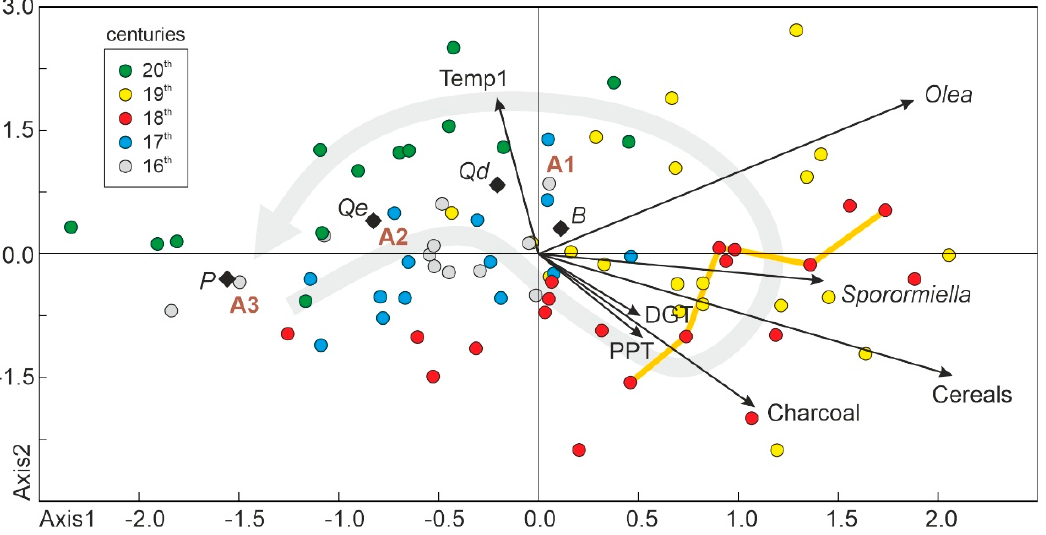
Figure 15. Scatter plot generated using the scores of the significant axes obtained in the RDA. Black arrows are the environmental variables, open diamonds are the selected taxa ( B , Betula ; P , Pinus ; Qd , deciduous Quercus ; Qe , evergreen Quercus ), and colored dots are the sample scores, using the same color code as in Figure 14. The gray arrow indicates the general successional trends. Samples corresponding to the phase of maximum deforestation (1740–1770 CE; Figure 4) are connected by a dark-yellow line.